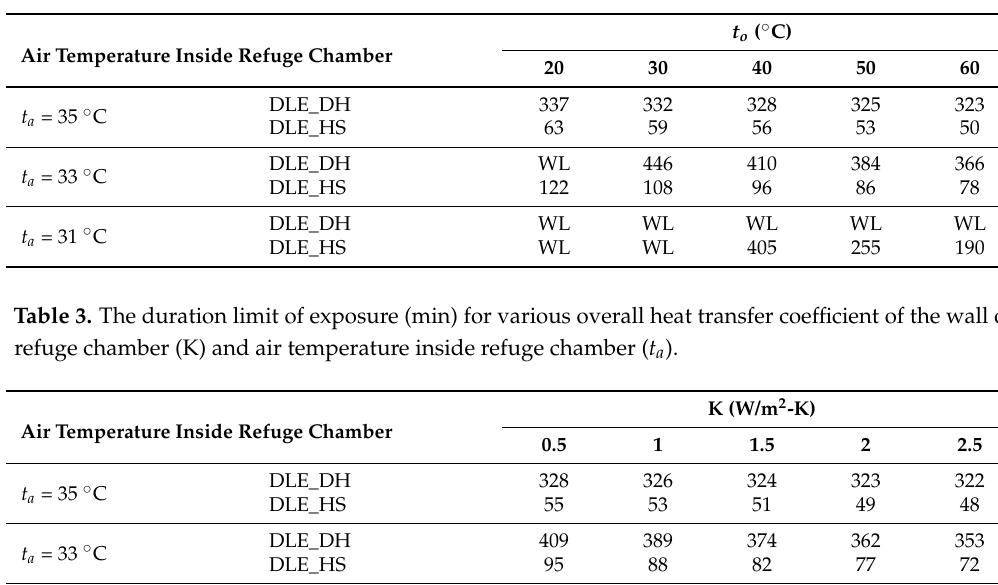
Table 2. The duration limit of exposure (min) for various air temperatures outside the refuge chamber ( t o ) and inside the refuge chamber ( t a ).